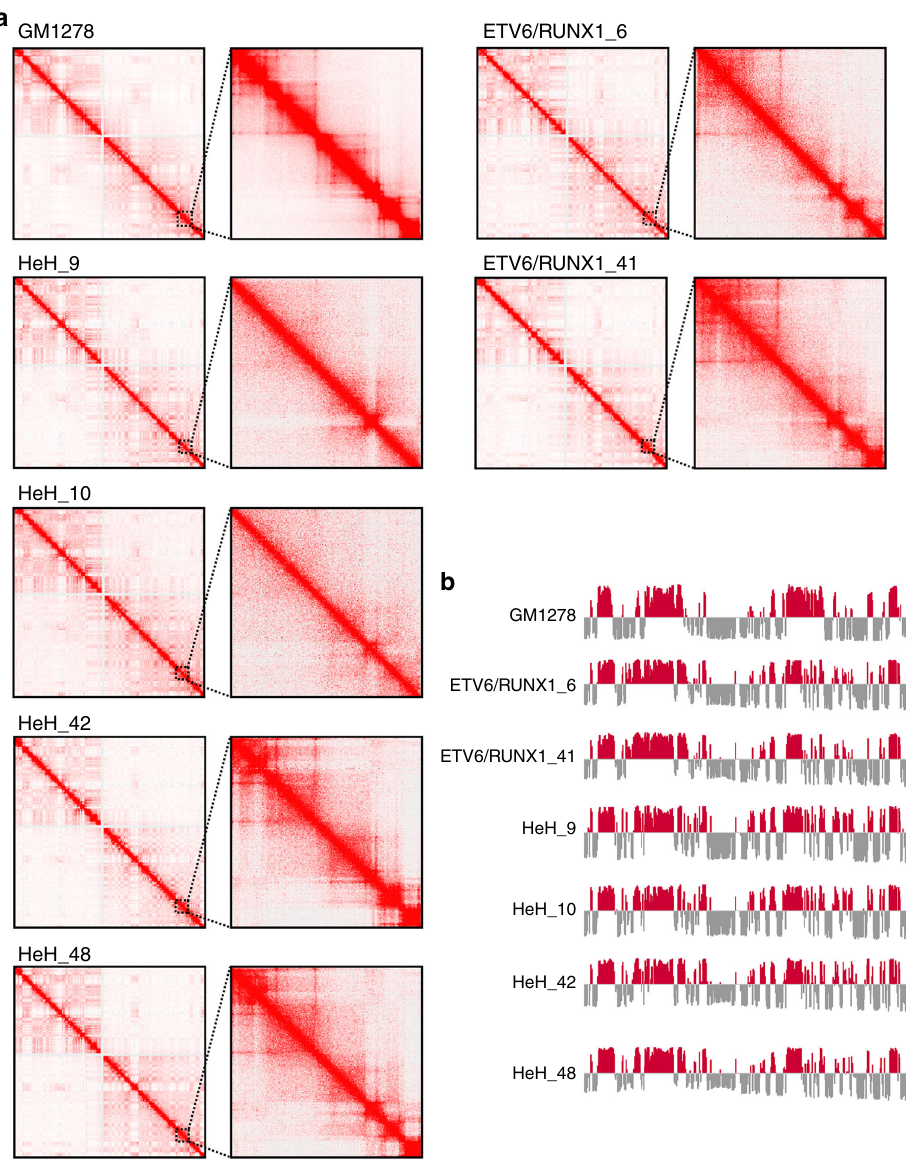
Fig. 5 Hi-C of high hyperdiploid and ETV6/RUNX1- positive cases. a Contact matrices from chromosome 3, selected because it is disomic in all cases and displays no structural aberrations. The whole chromosome at 250 kb resolution is shown to the left and the 161 – 172 Mb region at 25 kb resolution to the right. At a resolution of 250 kb, the interaction pro fi le is similar, showing that the general chromatin architecture is intact. However, at a resolution of 25 kb, it can clearly be seen that two of the high hyperdiploid cases (HeH_9 and HeH_10) have lost some topologically associating domains. b A/B compartment pro fi le of chromosome 3 in cell line GM12878 and the six leukemia samples at 500 kb resolution. The pro fi les were similar between the cell line and the